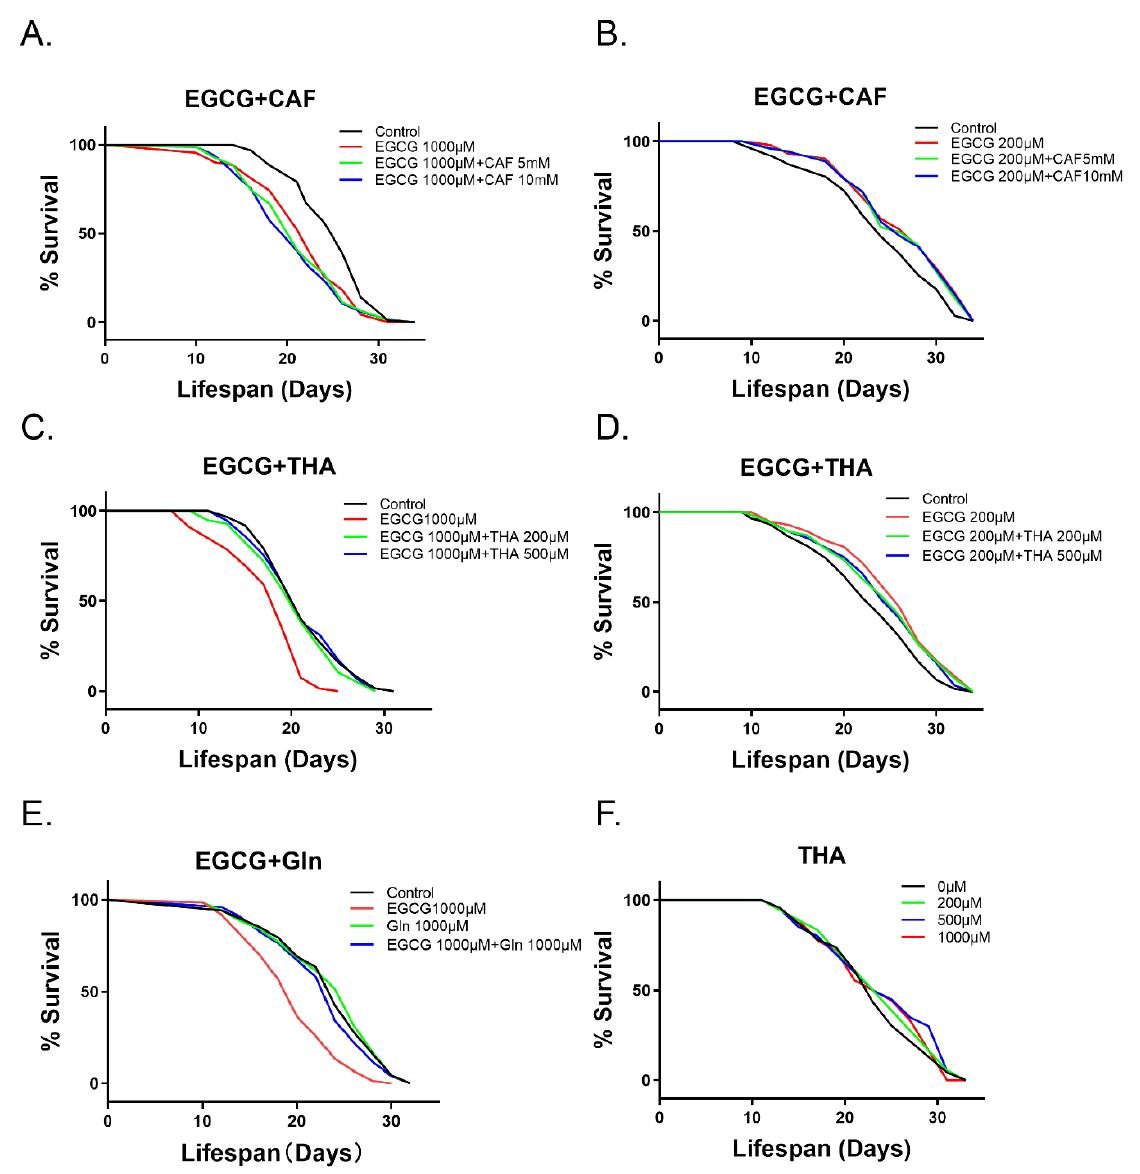
Figure 2. Survival of wild-type C. elegans treated with EGCG (200 and 1000 µ M), caffeine (CAF) (5 and 10 m M), theanine (THA) (200, 500, and 1000 µ M), and glutamine (Gln) (1000 µ M). ( A , B ) Survival curves with EGCG and caffeine; ( C , D ) survival curves with EGCG and theanine; ( E ) survival curves with EGCG and glutamine. ( F ) Theanine was tested at different concentrations to evaluate its ability to change the lifespan of the worms. Survival was recorded every other day, until all worms died ( n = 90–105 worms/treatment).